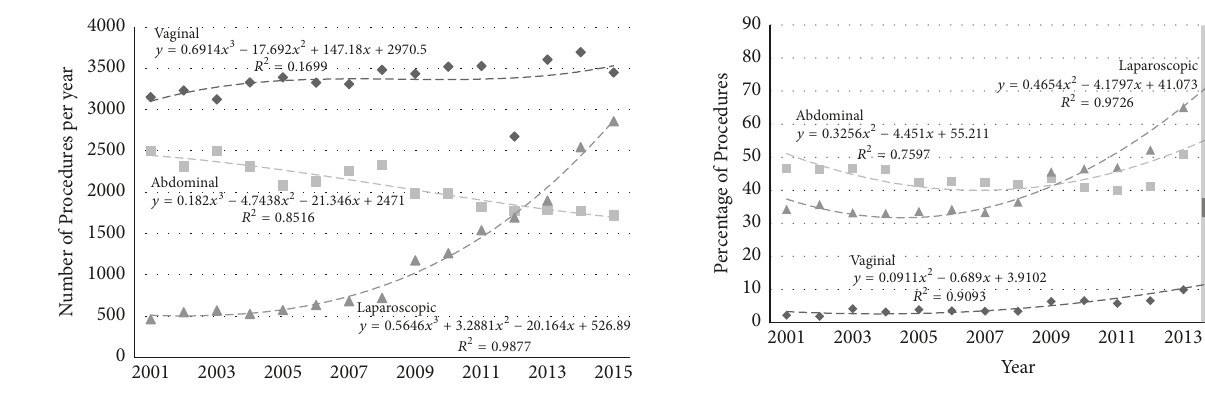
Figure 6: Percentage of procedures involving removal of the adnexae by route of hysterectomy ( X vaginal, ◼ abdominal, and 󳵳 laparoscopic) in Australia for women aged 35–54 years. The epoch in which guidance advised opportunistic salpingectomy is shaded.